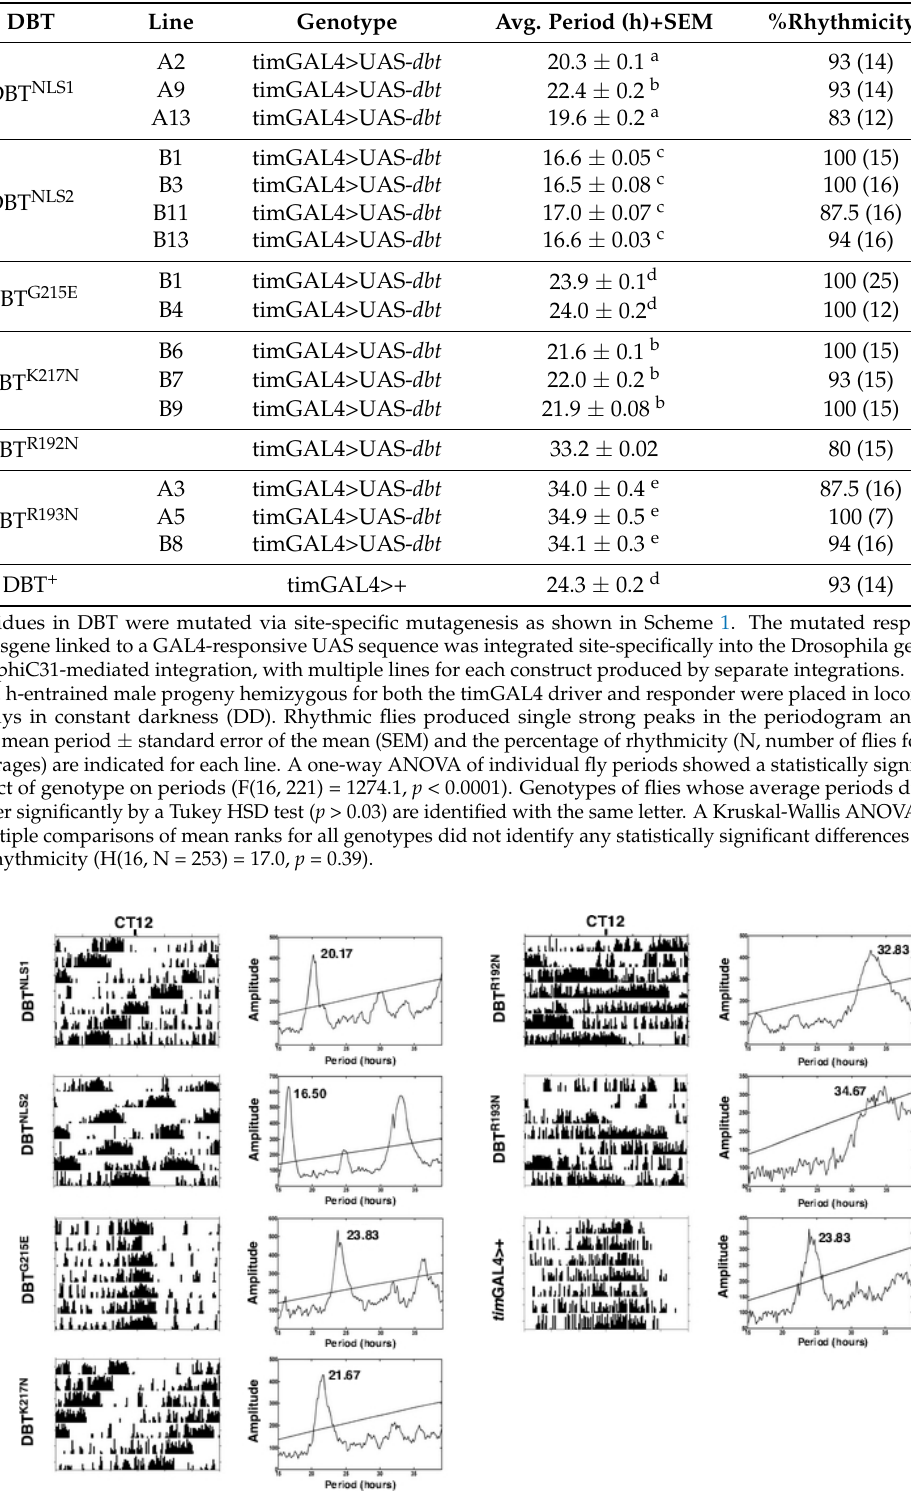
Table 1. Effects of Mutations Around the DBT NLS and Phosphate-Binding Domain.